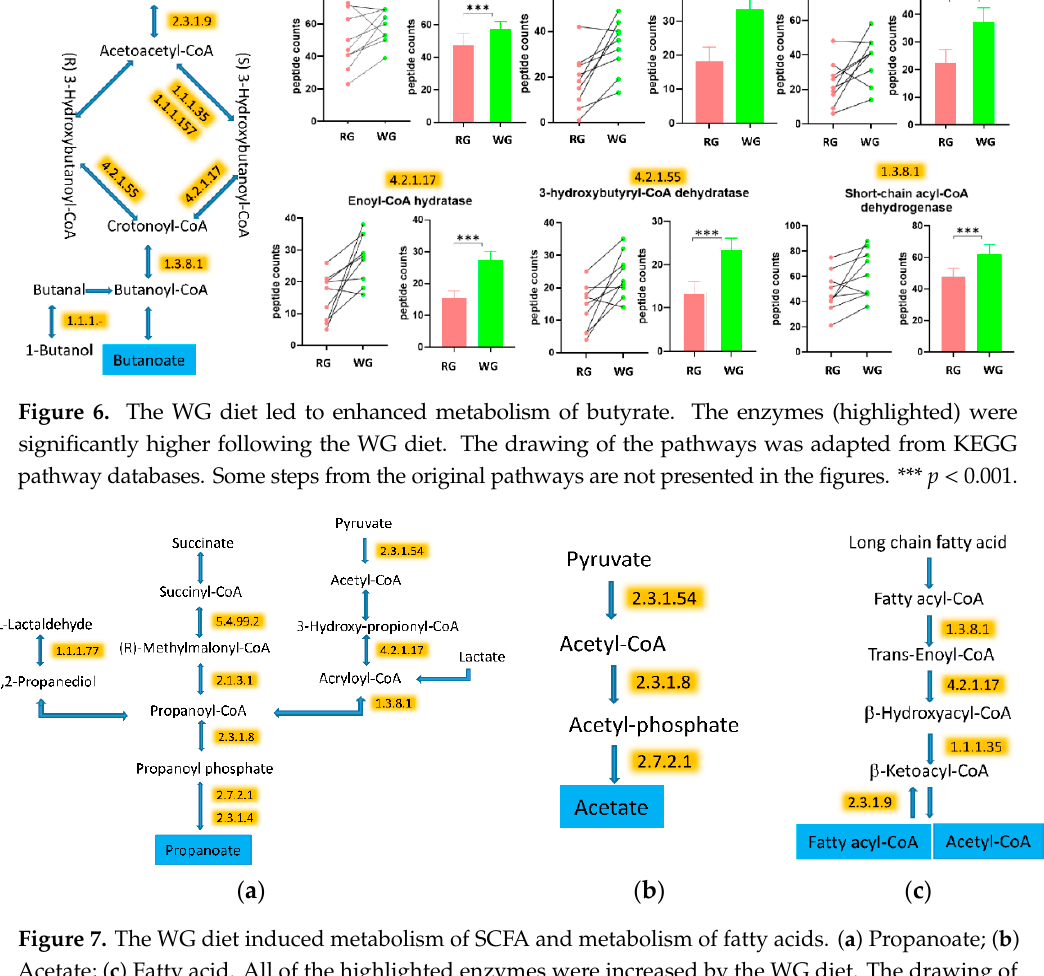
Acetate; ( c ) Fatty acid. All of the highlighted enzymes were increased by the WG diet. The drawing of